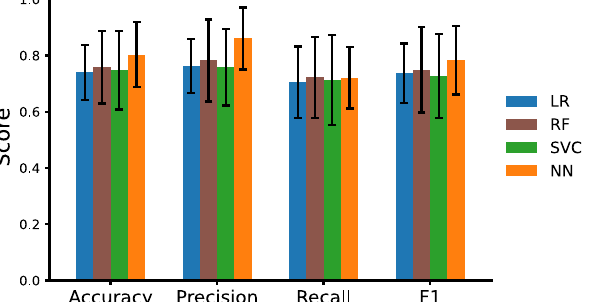
Figure 3. Model Performance for AD detection task using the data2vec embeddings from the ADReSSo unseen test data. The error bar in each metric denotes the 95% confidence interval.